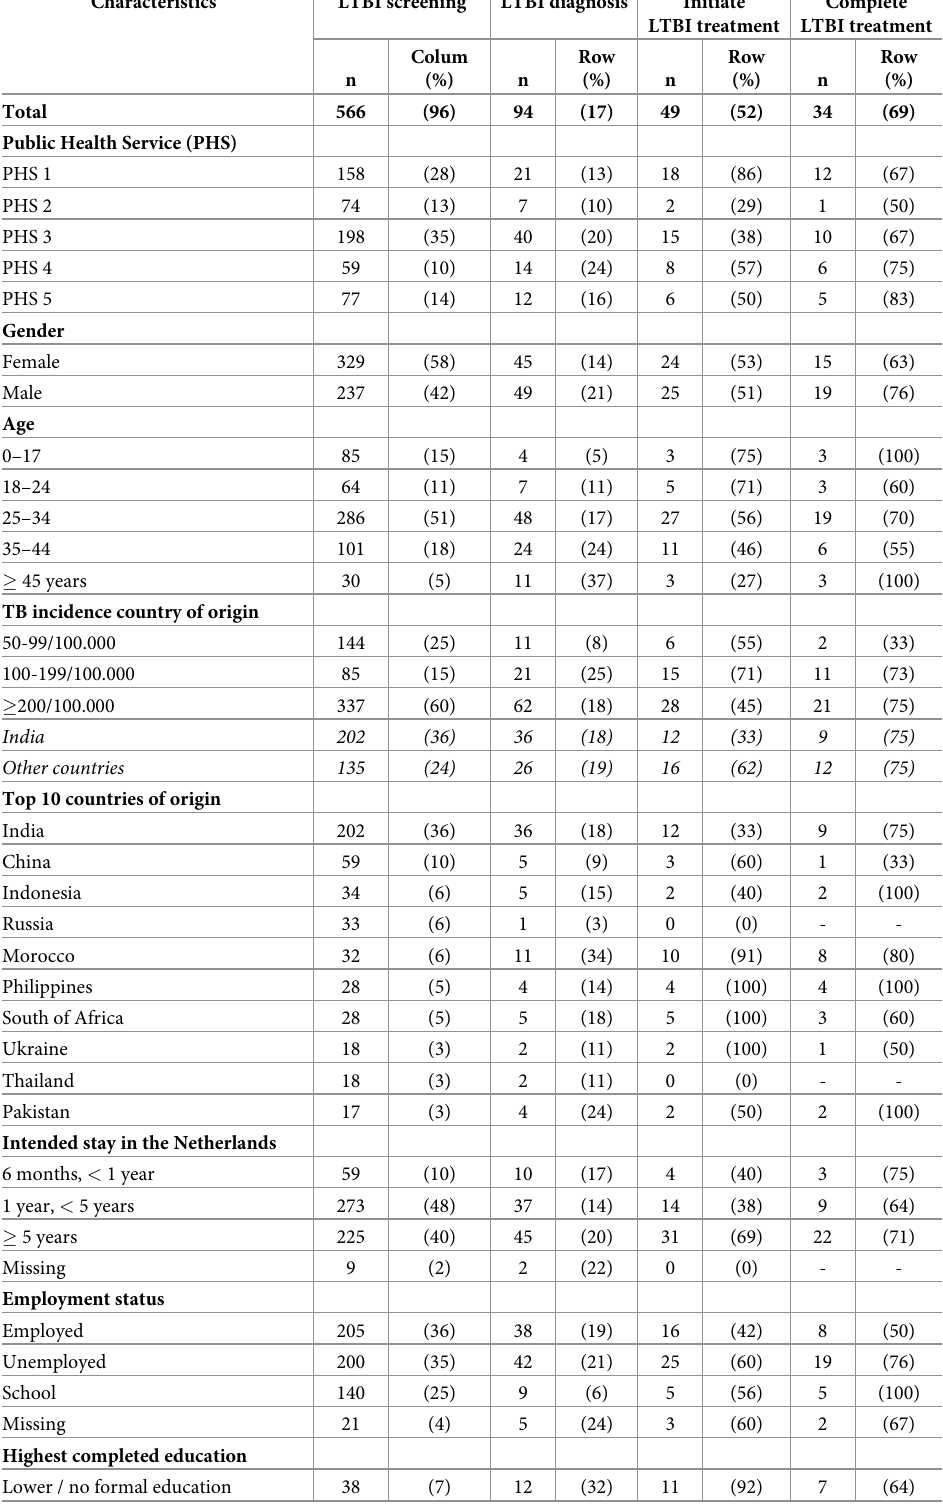
Table 1. Descriptive statistics of the study